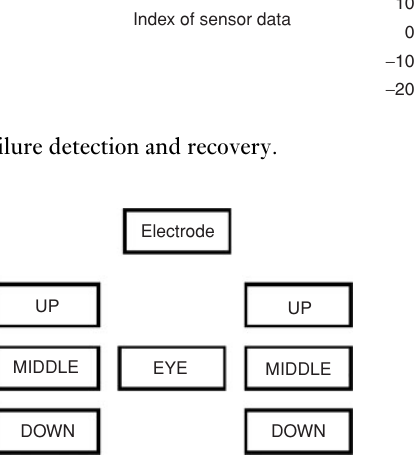
Figure 19 The configurations of the electrodes.